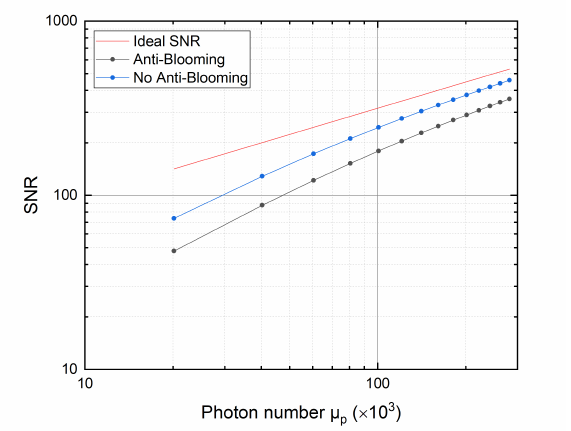
Figure 9. SNR of the sensor with and without anti-blooming clocking, as well as the SNR of an ideal sensor. Dots indicate the measured SNR curves, and the solid line corresponds to the ideal SNR of a sensor.